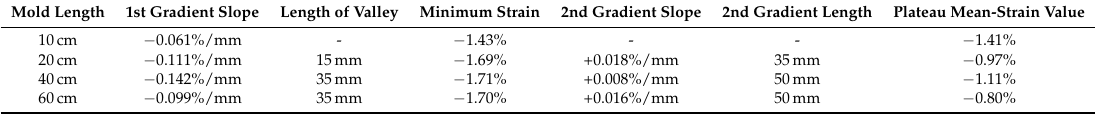
Table 3. Summary of key features of the strain along the length of differently sized molds. For the 10cm sample, the plateau mean-strain value is the mean value after the initial